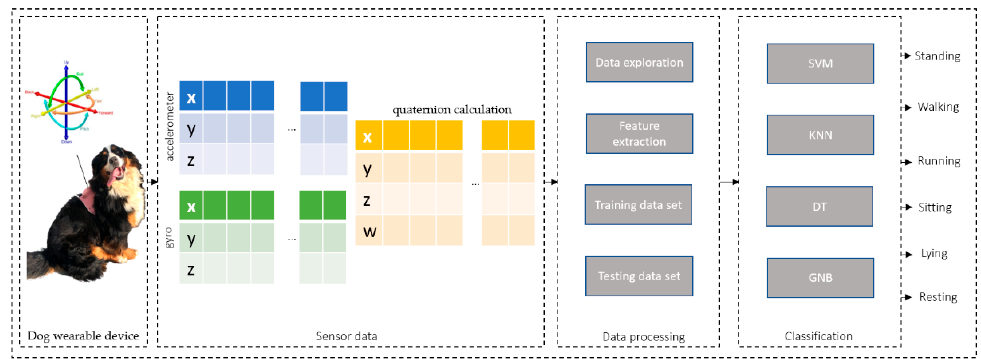
Figure 2. General process of the activity recognition system based on high-dimensional data.